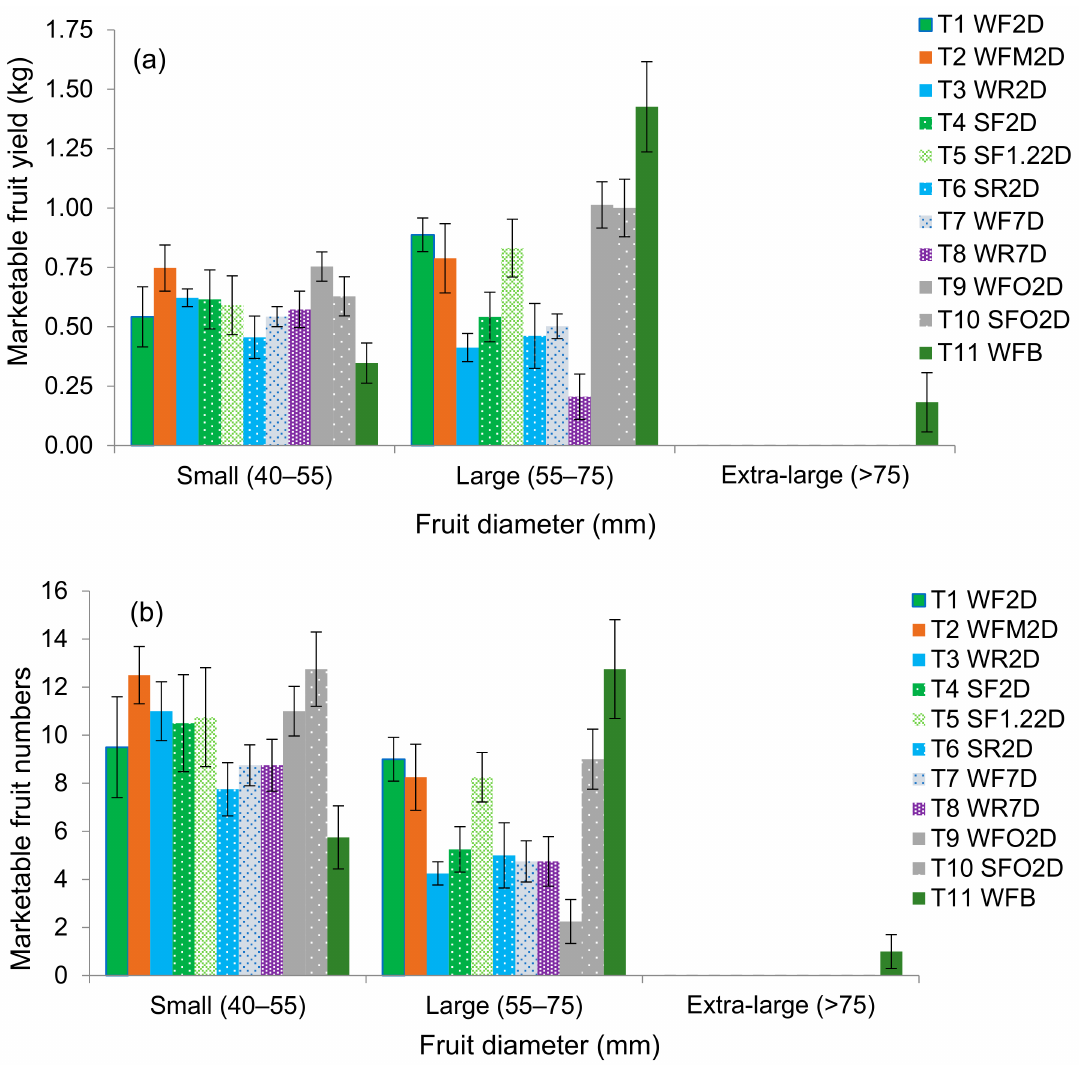
Figure 2. Comparison of ( a ) marketable yield and ( b ) number of fruits in each fruit grade. Error bars indicate standard error. See Table 2 for treatment